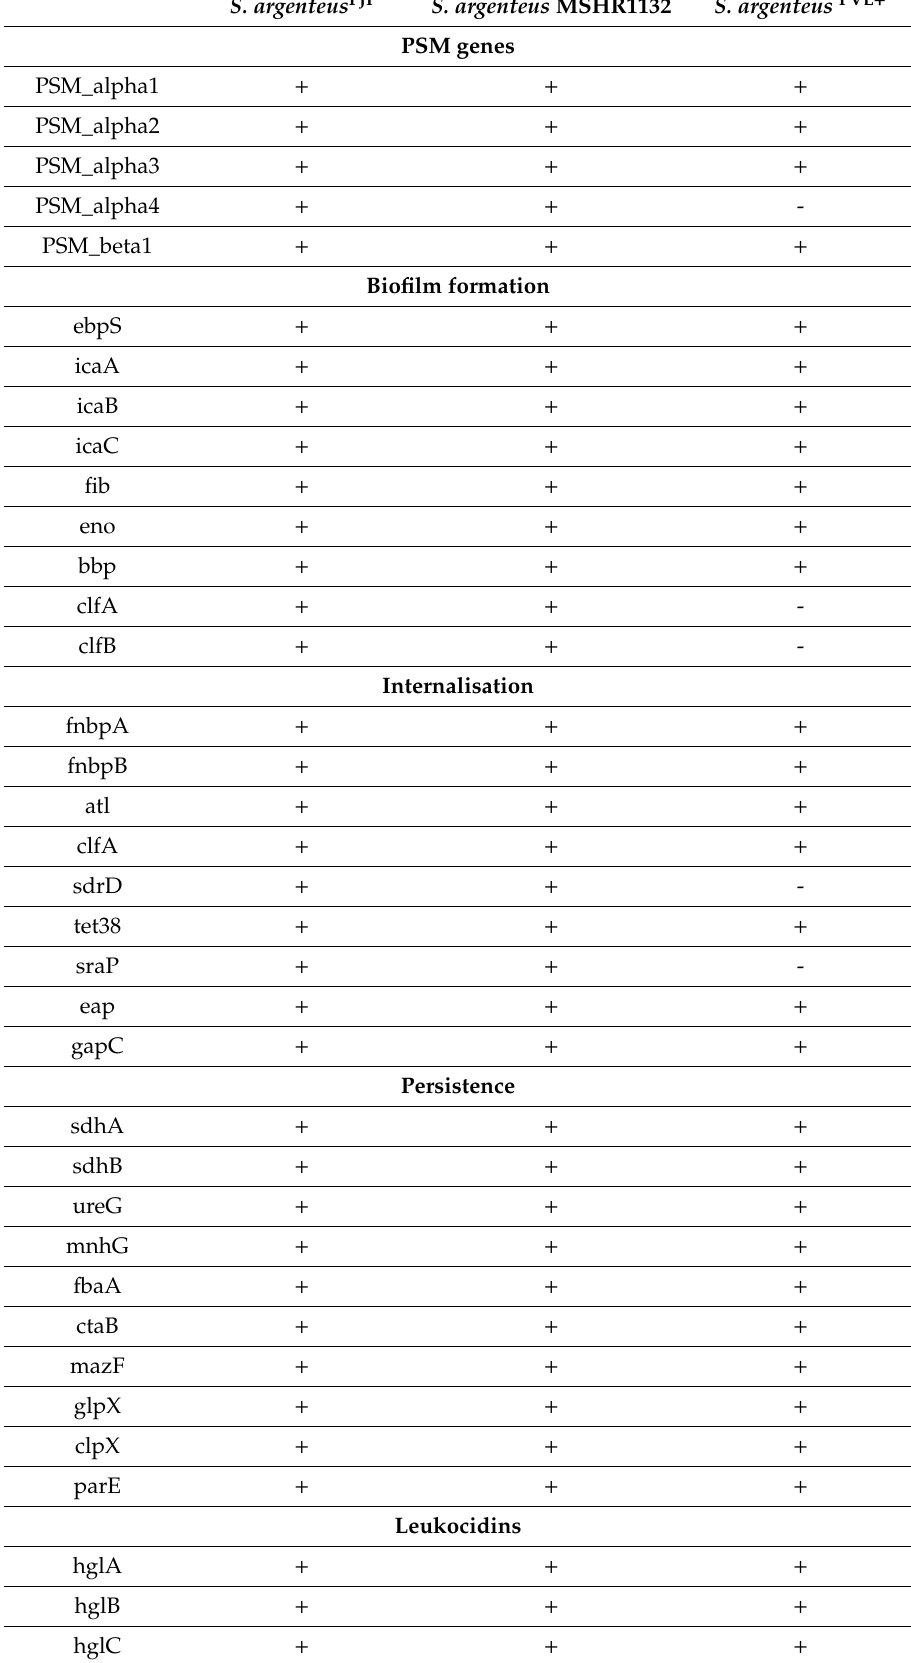
Table 2. Presence ( + ) or absence ( − ) of genes involved in S. aureus virulence, in the S. argenteus strains